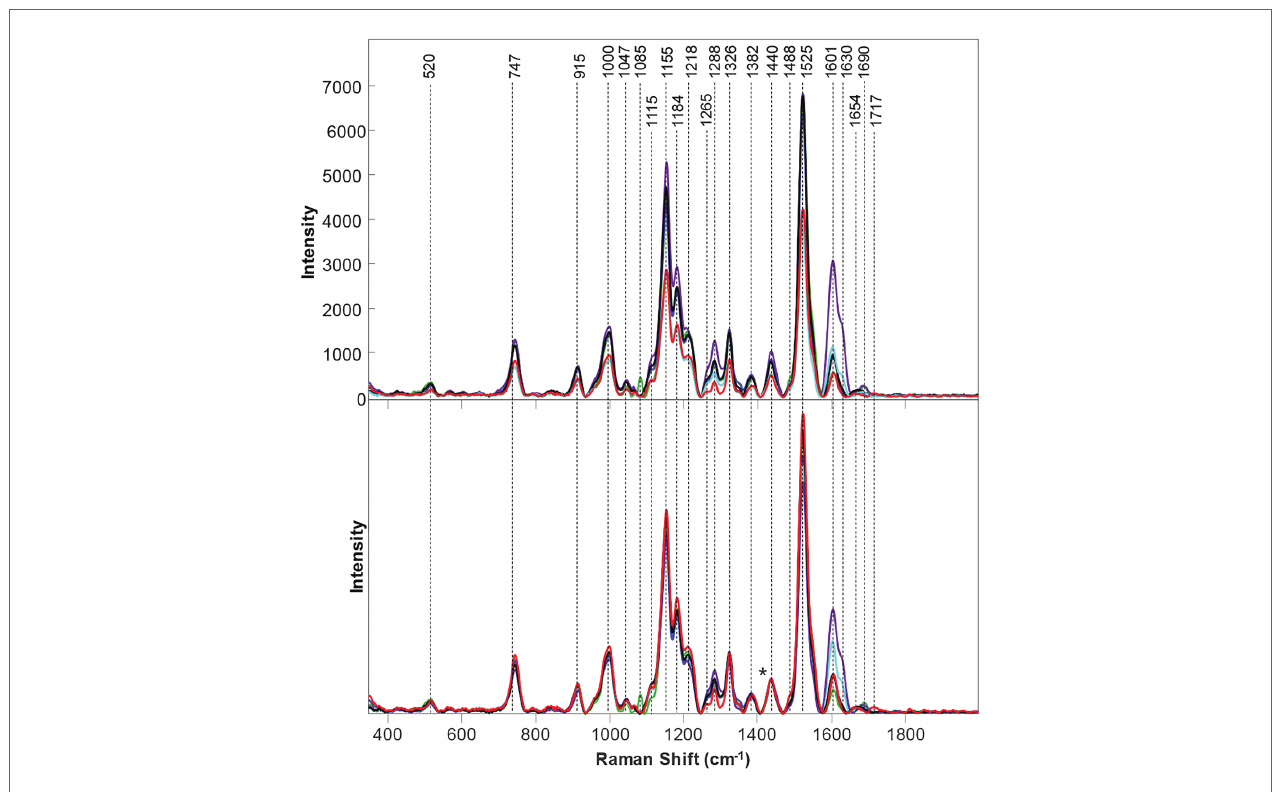
FIGURE 8 | Baseline-corrected (top) and area normalized (bottom) Raman spectra collected from poison ivy (red), palmer amaranth (green), water oak (blue), white crownbeard (marine), buckbrush (purple) and saw greenbrier